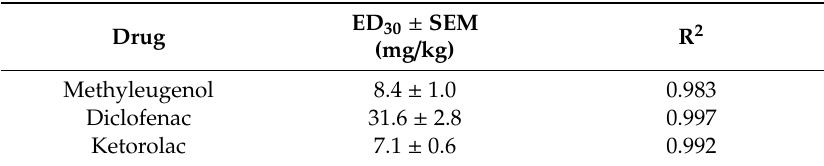
Table 1. Antinociceptive e ff ective dose 30 (ED 30 ) were derived from the formalin test applied to mice. Data were established by linear regression of the dose-response curves of methyleugenol, diclofenac, and ketorolac when administered